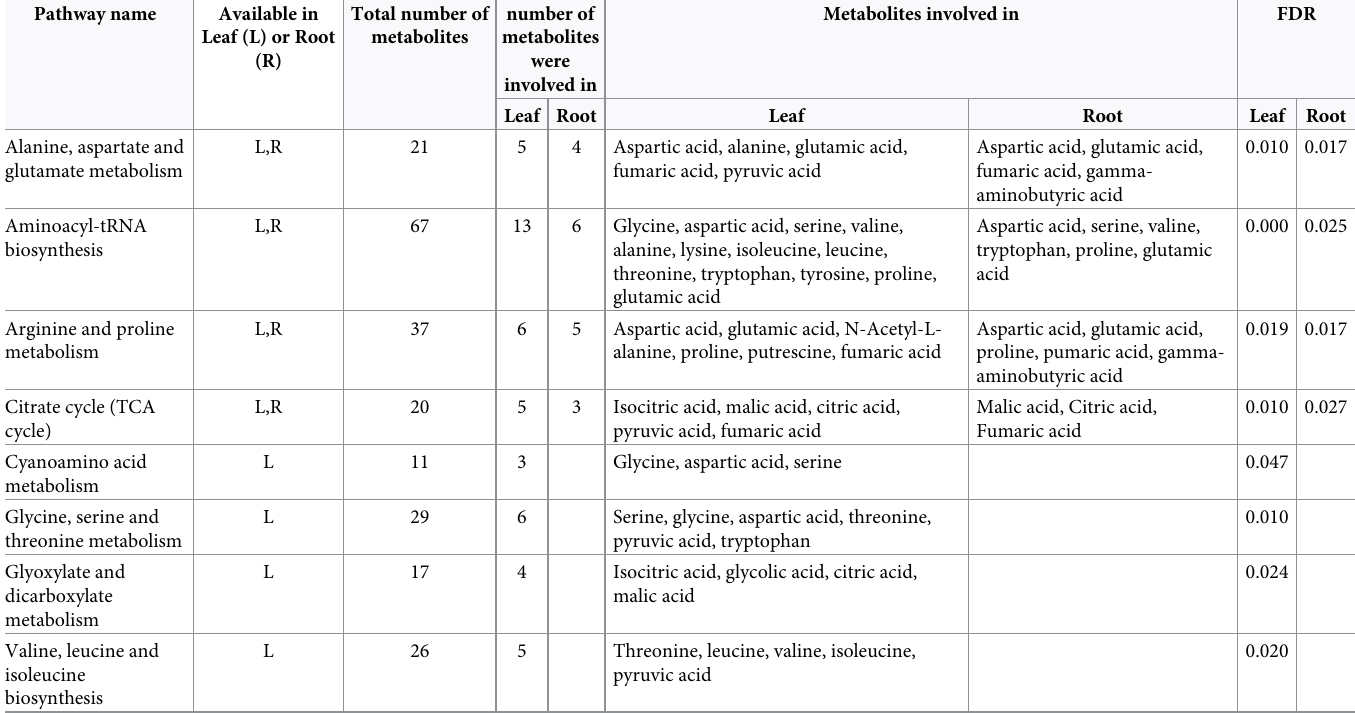
Table 5. Pathway names, total metabolites involved in those pathways, metabolites significantly accumulated in present study (hits), and false discovery rate (FDR) in wheat flag leaves and roots of LA754 identified by Pathway Analysis of MetaboAnalyst 3 using Oryza sativa japonica as the pathway library.